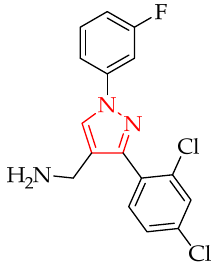
Figure 2. Some thiosemicarbazones endowed with antidiabetic activity.